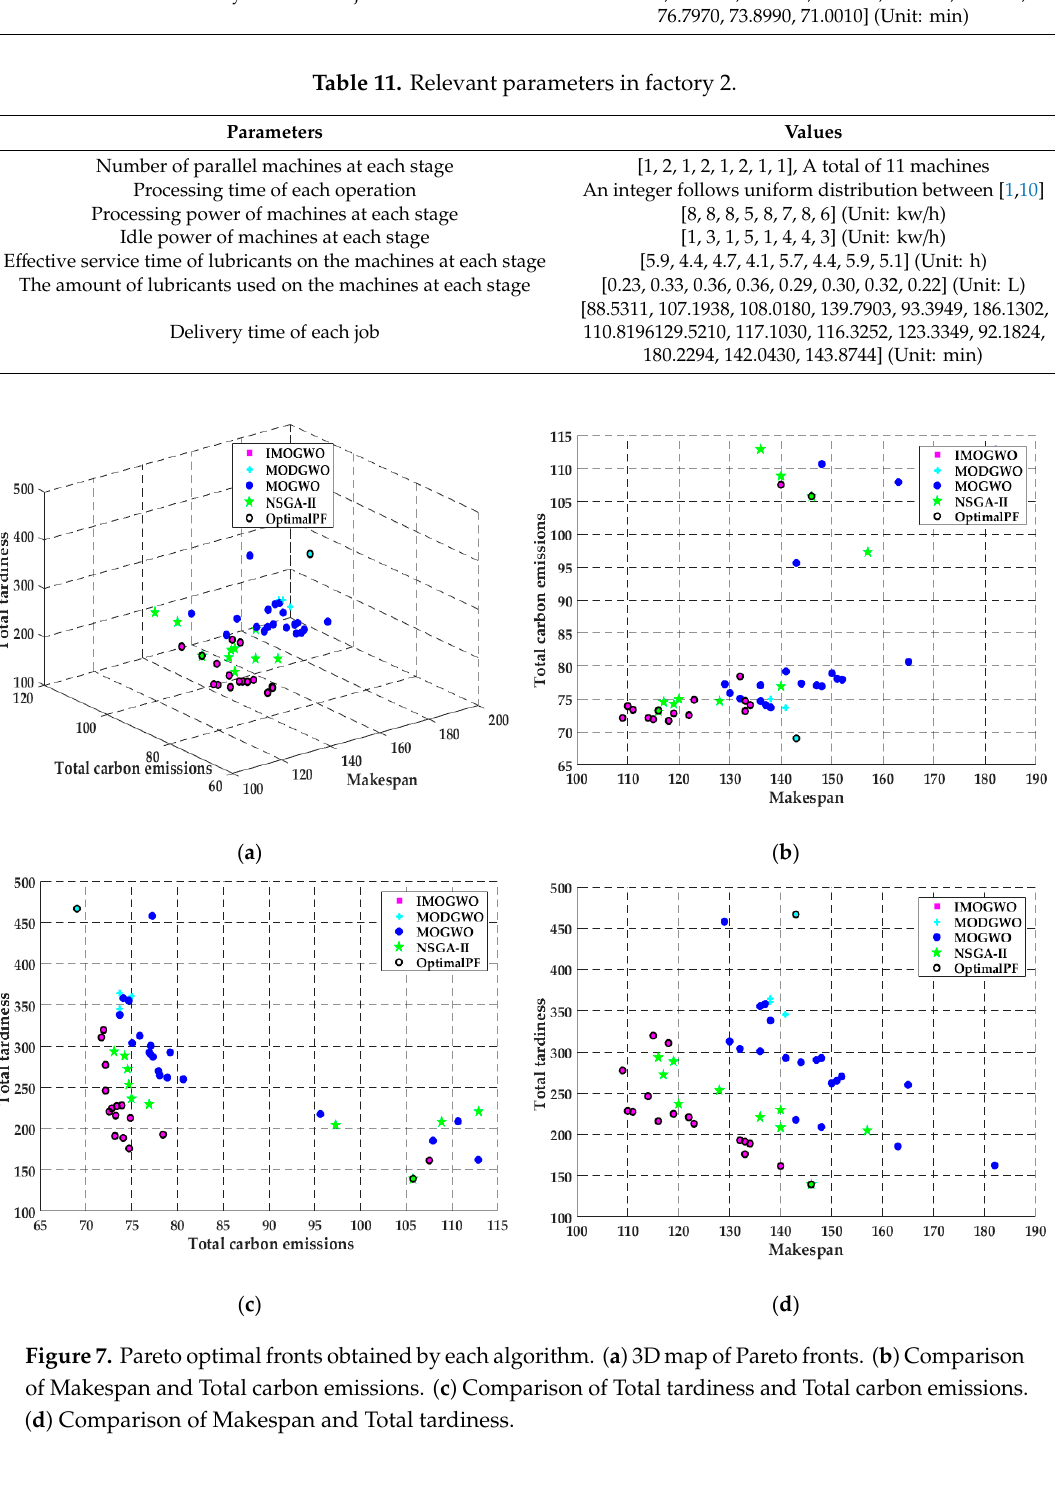
Table 11. Relevant parameters in factory 2.